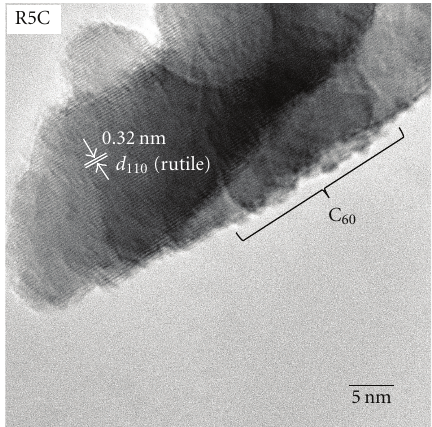
Figure 5: High resolution TEM image of the R5C